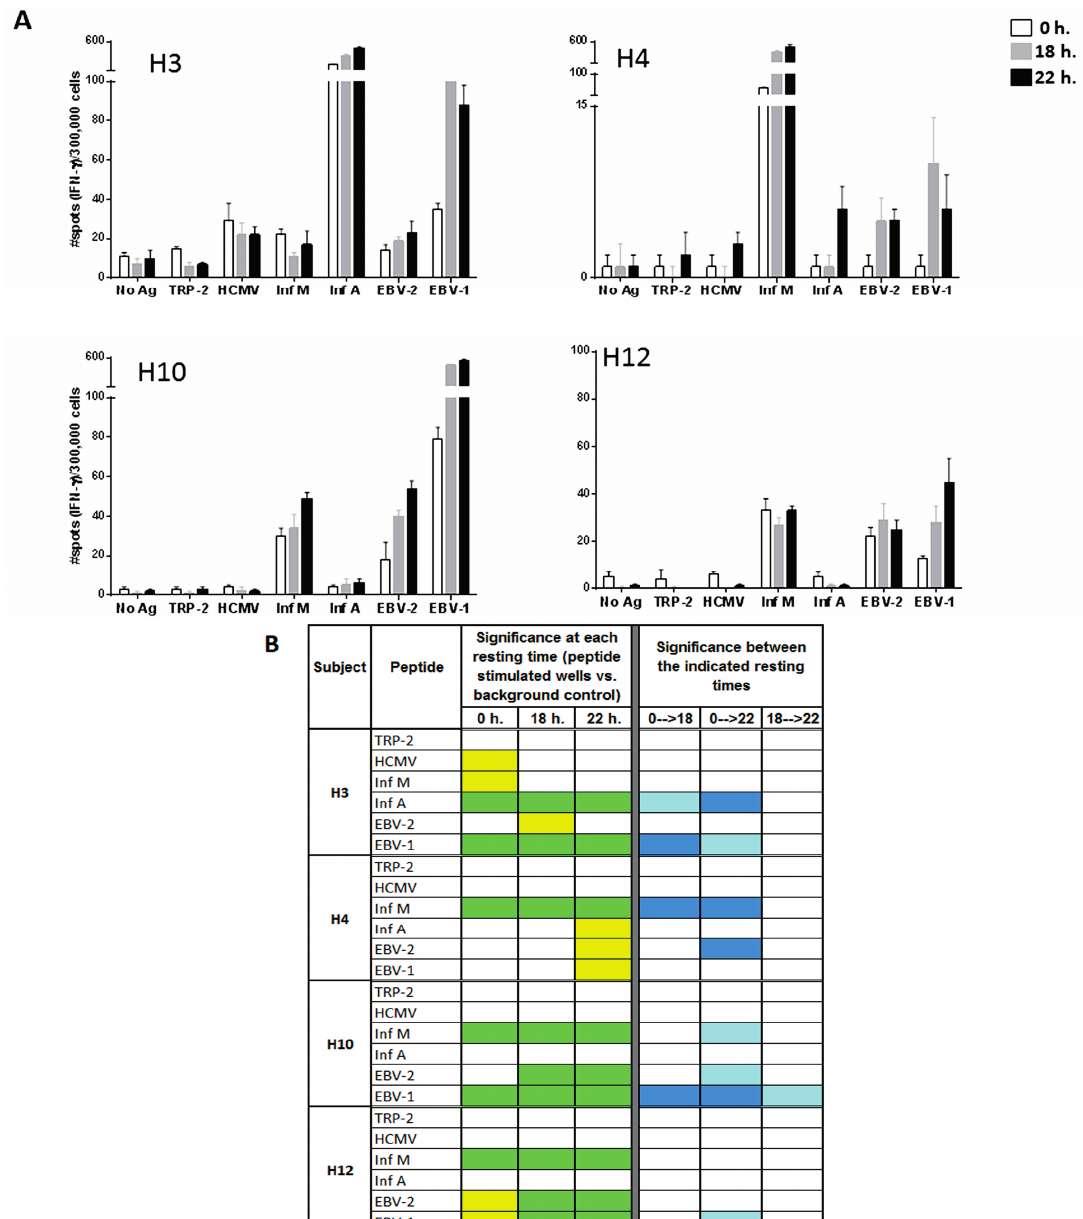
Figure 3. Resting of PBMC samples prior to the evaluation of individual peptides of the A2-CEF pool increases the magnitude of response detected by IFN γ ELISPOT. PBMC samples from the indicated donors where thawed and seeded in the presence or absence (no Ag, background control) of peptide. The peptides included TRP-2 and each of the individual peptides from the A2-CEF pool. PBMCs were not rested (0 h) or rested 18 h or 22 h prior to testing. ( A ) Results are the average of spots from triplicate wells for wells tested with peptide and from six replicates in the absence of peptide. ( B ) The statistical significance for the response at each of the rest times was determined by modified DFR(2x) or DFR(eq) after Westfall–Young max-T correction, and p -values <5% are shown in green or yellow, respectively. The statistical significance of the responses obtained for the three different resting time points were determined by a DFR-like permutation method with Westfall-Young max-T correction; 5% or 10% significances are denoted by dark blue or light blue,